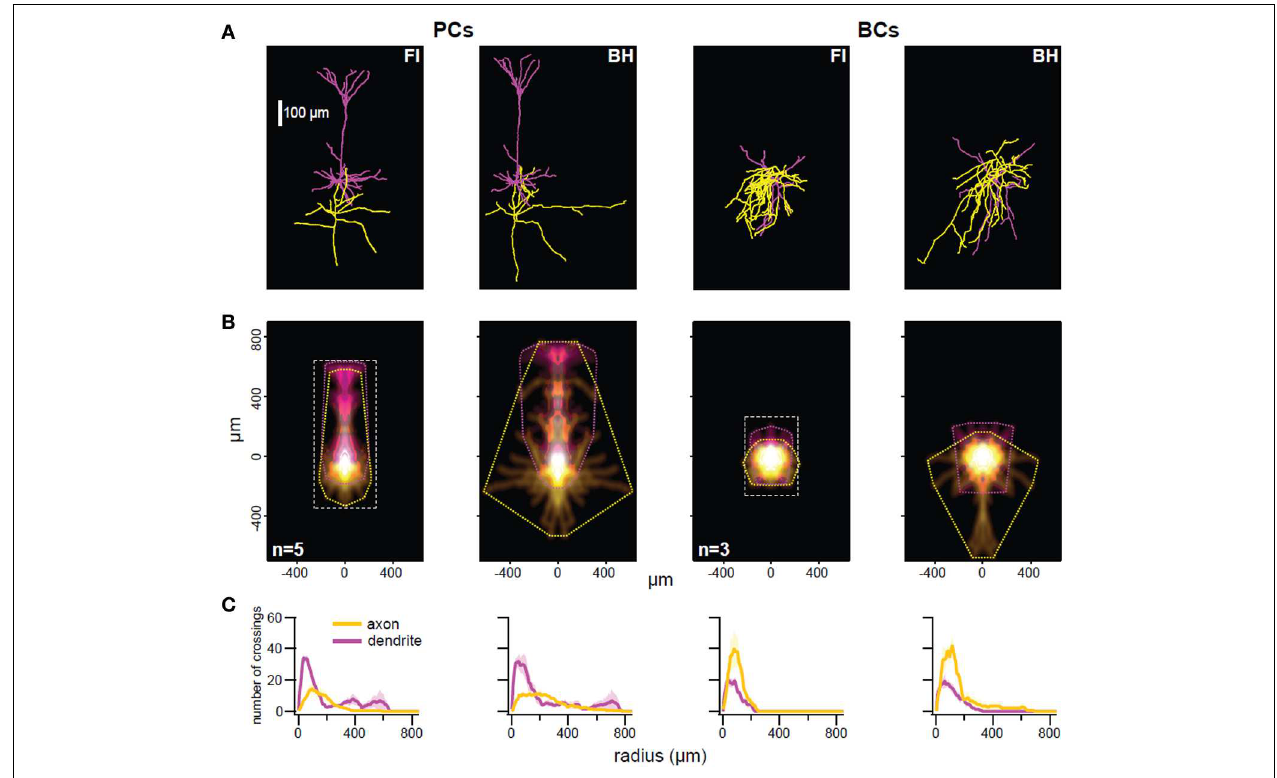
FIGURE 2 | The BH approach enables better reconstruction of thin distal arbors. (A) Representative reconstructed morphology pairs of a single pyramidal cell (PC; left) and basket cell (BC; right) generated with fluorescence imaging (FI) or biocytin histology (BH). Reconstructions appeared qualitatively similar, but BH allowed for tracing of longer collaterals. There was also some expansion of BH reconstructions in XY, perhaps due to compression (see main text). (B) Density maps indicate average distribution of axonal (yellow) and dendritic (magenta) arbors, whilst convex hulls (dotted lines) show maximum extent. Reconstructions are aligned on soma. For FI reconstructions, the imaged area is represented by a dotted rectangle, outside of which any arbors would have been missed. Axonal convex hull width was larger in BH reconstructions for PCs ( p < 0 . 01) and BCs ( p < 0 . 01),